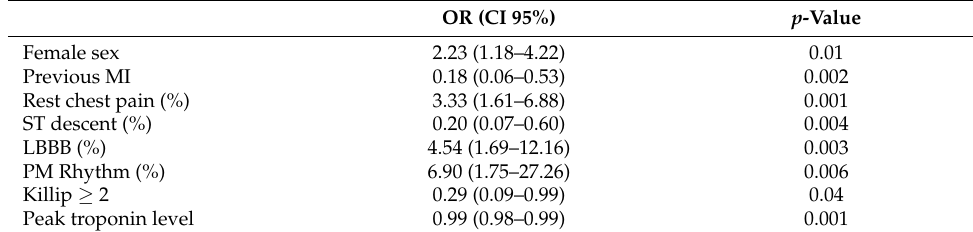
Table 3. Predictors of MINOCA. Multivariate